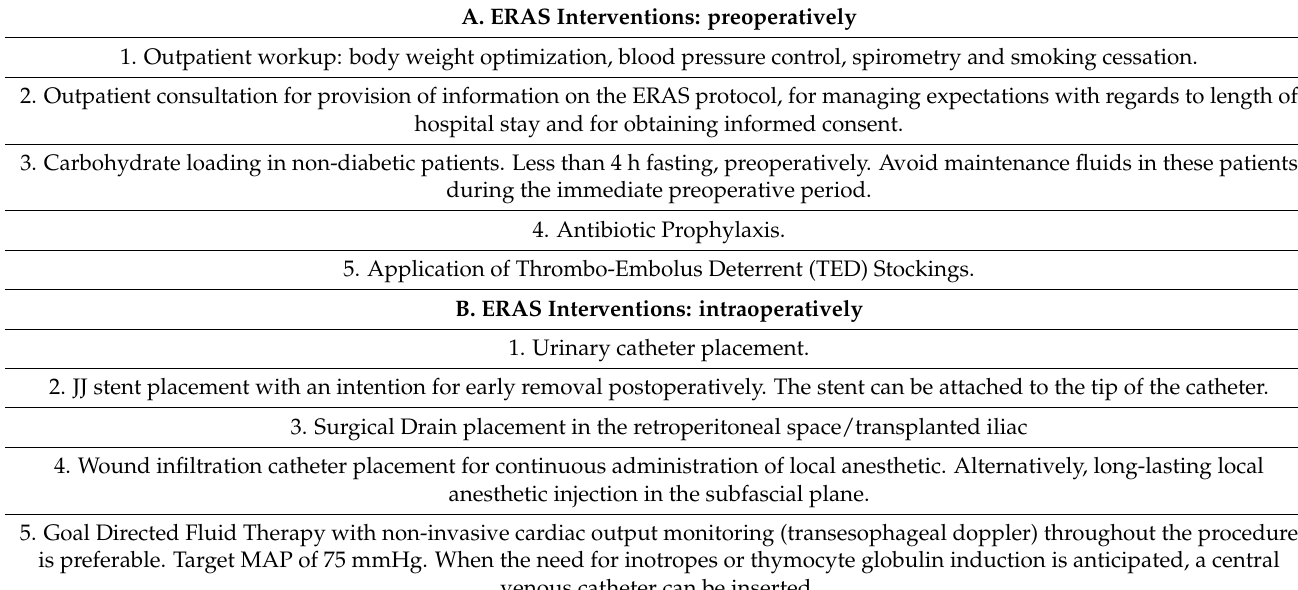
Table 5. The different synergistic ERAS interventions presented in the included studies are summarized. (A)